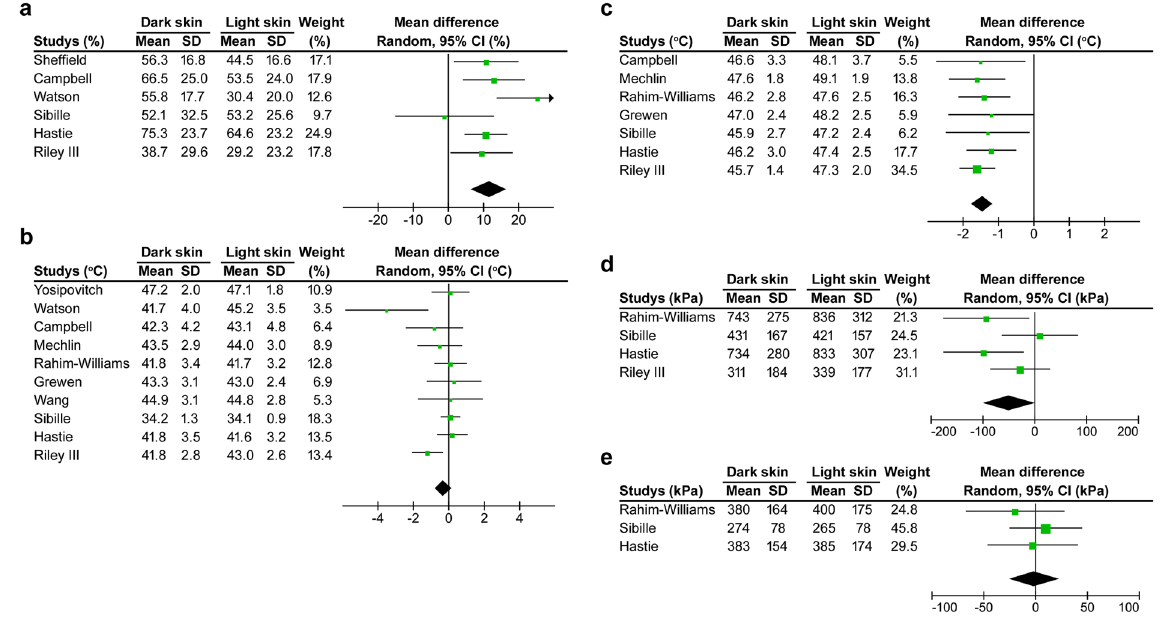
Figure 1. Forest plots of the mean differences in heat and pressure pain sensitivities between dark and light skin human cohorts. Study name is defined as the last name of the first author and all studies are listed in Table S1. ( a ) Heat pain intensity (% of visual analogue scale) in the forearm to 48 or 49 °C stimulation is higher in dark skin cohort than light skin cohort (6 studies). Heterogeneity among the studies was moderate ( I 2 = 44, P < 0.11). ( b ) There is no difference in heat pain threshold (the first painful temperature) in the forearm between the two cohorts (10 studies). However, there is a trend toward lower heat pain thresholds in the dark skin cohort. Heterogeneity among the studies was moderate ( I 2 = 46, P < 0.06). ( c ) Heat pain tolerance (intolerance temperature) in the forearm is lower in dark skin cohort than light skin cohort (7 studies). There is no heterogeneity among the studies ( I 2 = 40, P < 0.98). ( d ) There is no difference in the pain pressure threshold in trapezius muscle (4 studies). However, there is a trend toward lower pressure threshold of the dark skin cohort than that of the light skin cohort ( P = 0.05). Heterogeneity among the studies is moderate ( I 2 = 46, P < 0.13). ( e ) There was no difference in the pain pressure threshold in the masseter muscle (3 studies). There is no heterogeneity among the studies ( I 2 = 40, P <